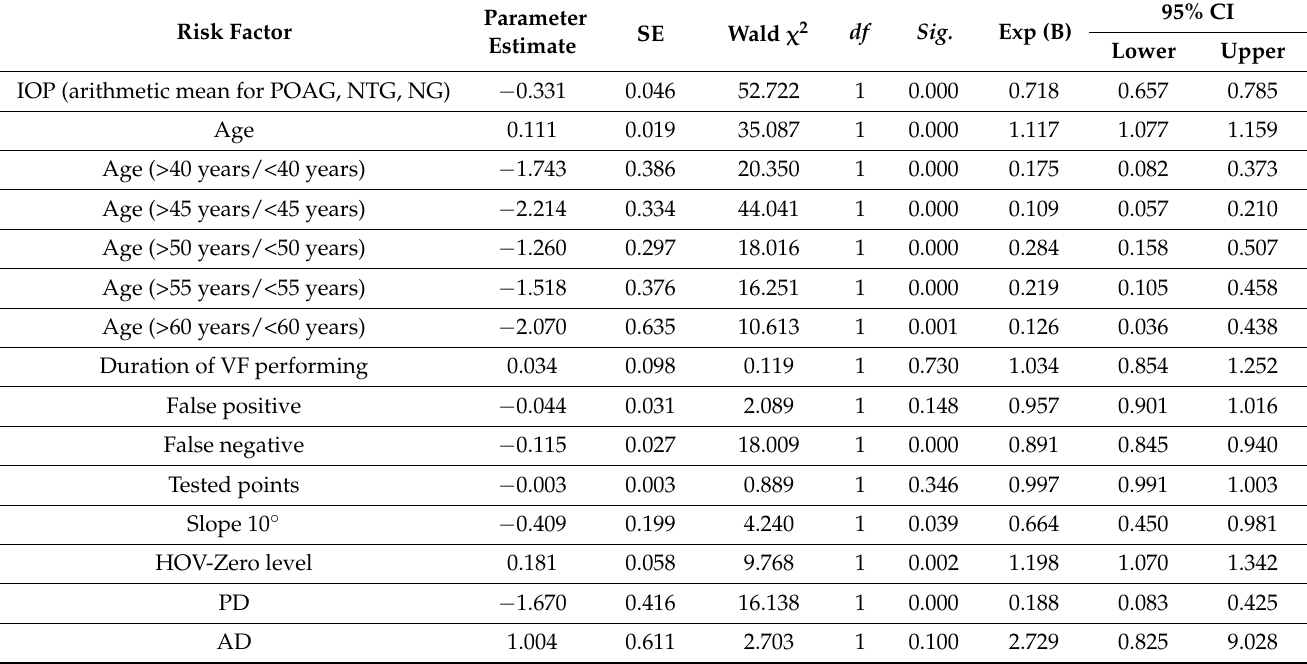
Table 7. Distribution of binomial logistic analysis results for OAG (POAG and NTG) and NG patients at the first consultation.